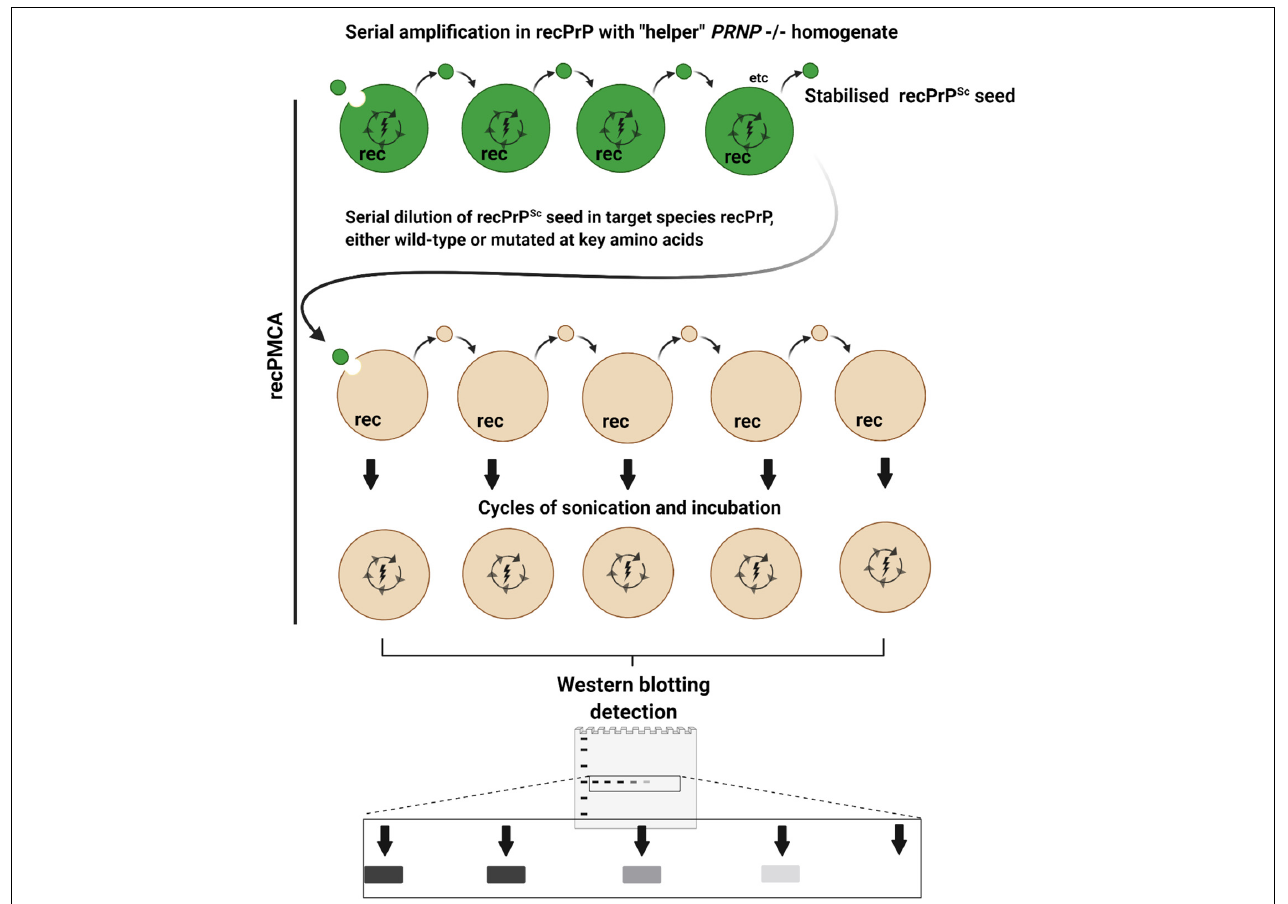
FIGURE 4 | Recombinant PMCA (recPMCA). In recPMCA, bacterially expressed and purified recombinant PrP (recPrP) is used as a substrate for conversion. Firstly, PrP Sc from infected tissue of the species of origin (dark green) is propagated by saPMCA using recPrP from the same species to produce recPrP Sc as an end product, detectable on western blots as a single band. Propagation in recPMCA requires the presence of “helper” brain homogenate from PRNP –/– animals. Thus, the effects of variable PrP C expression, glycosylation and cofactors that affect conventional PMCA reactions are largely eliminated, to focus primarily on the effect of sequence and conformational compatibility. The levels of recPrP Sc are normalized and the recPrP Sc is serially diluted in recPrP from the target species before being subjected to cycles of sonication and incubation. Species barriers are assessed according to how abruptly PMCA conversion is diminished by serial dilution of the seed: i.e., if the barrier is low, highly diluted seed will still cause conversion. Mutant forms of recPrP can easily be generated to examine the effect of amino acid substitutions on species barriers.